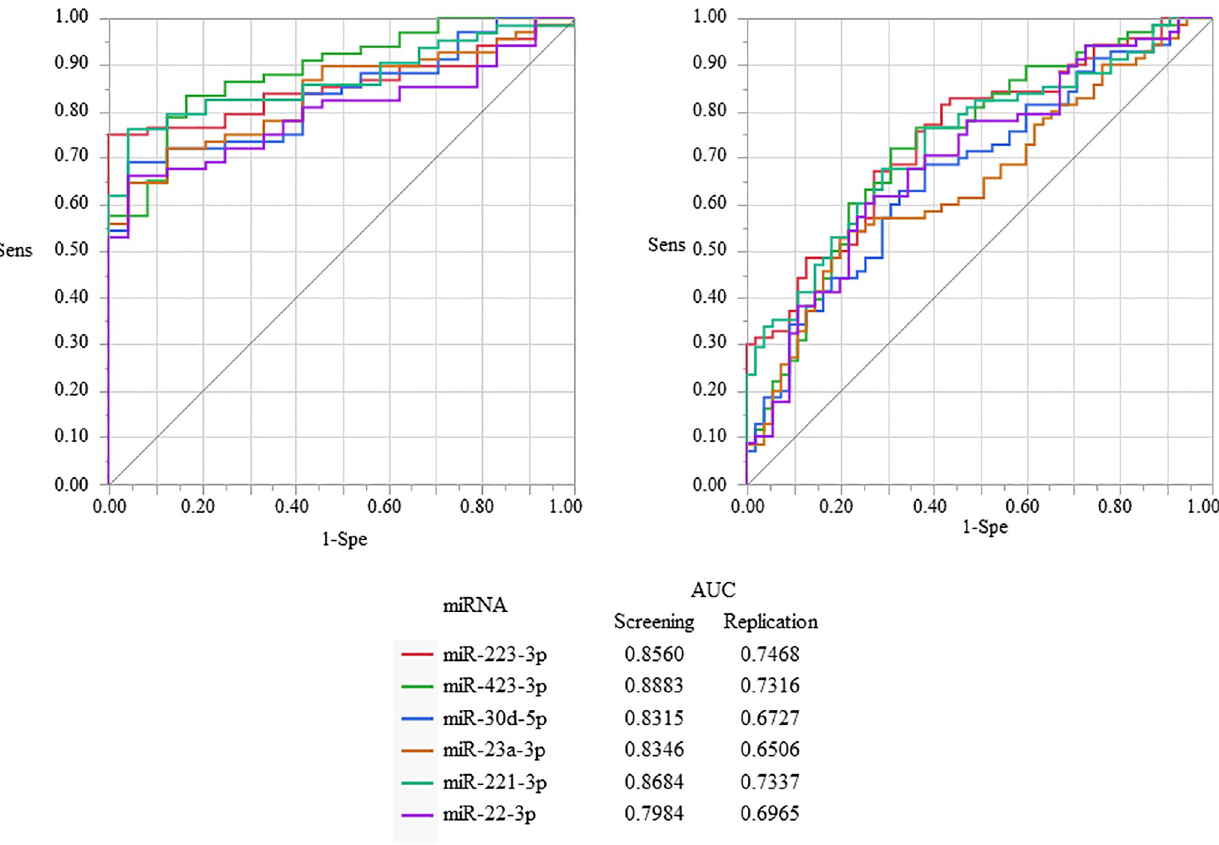
Fig 2. Receiver-operating characteristic (ROC) curves and the area under the ROC curve (AUC) of the significant miRNAs. The AUC of all miRNAs showing significantly different expressions between the BrS patients and the controls in the screening cohort was more than 0.8. The AUC of miR-423–3p was the highest at 0.8883. The AUC of the significant miRNAs in the replication cohort was lower than those in the screening cohort.